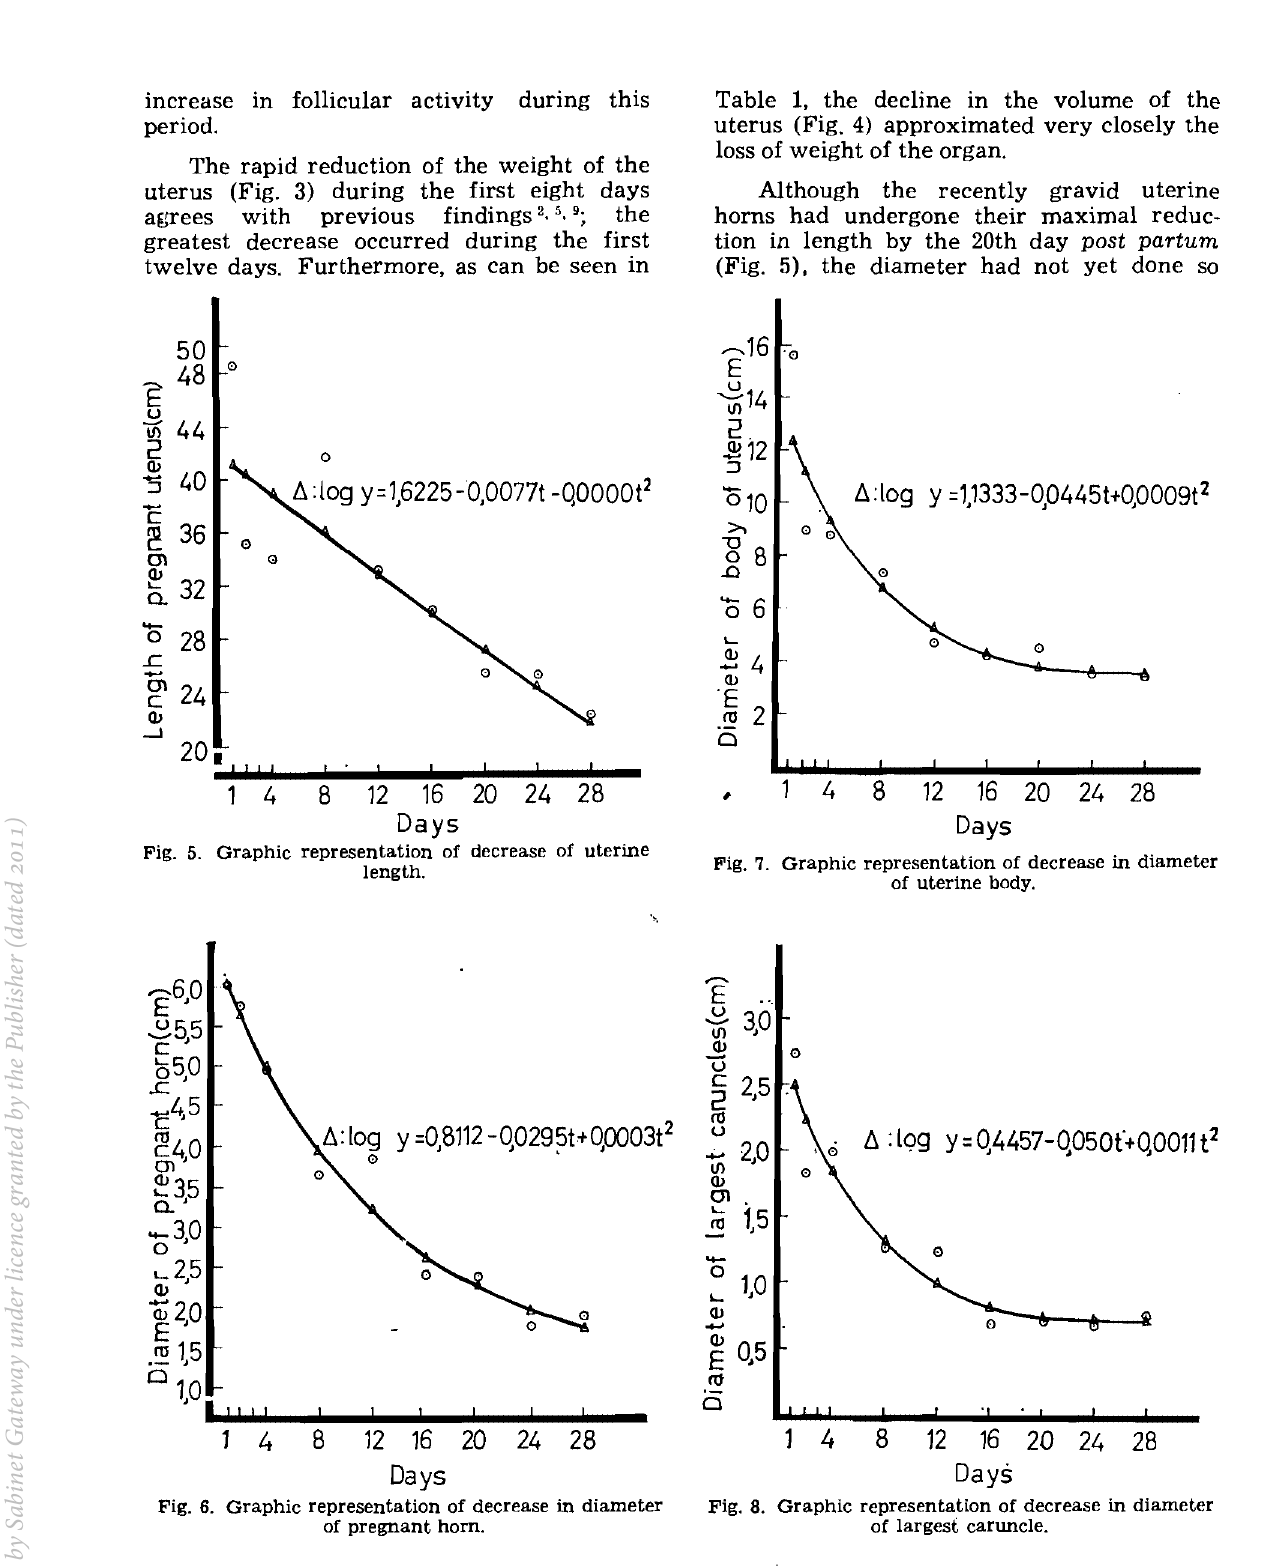
Fig. 6. Graphic representation of decrease in diameter of pregnant horn.